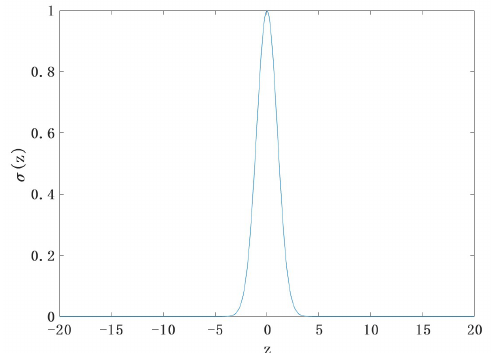
Figure 4. Gaussian distribution of z after improvement.